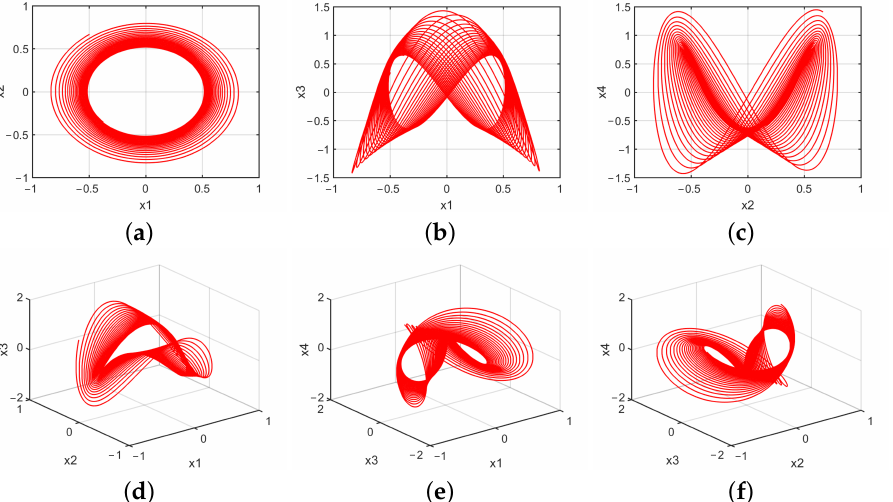
Figure 10. Phase portraits of the orbits (no periodic solution) when f 1 < f 12 : ( a ) ( x 1 , x 2 ) plane; ( b ) ( x ) plane; ( c ) ( x ) plane; ( d ) ( x ) space; ( e ) ( x ) space; ( f ) ( x ) 2 , x 4 2 , x 3 , x 4 1 , x 3 1 , x 2 , x 3 1 , x 3 , x 4